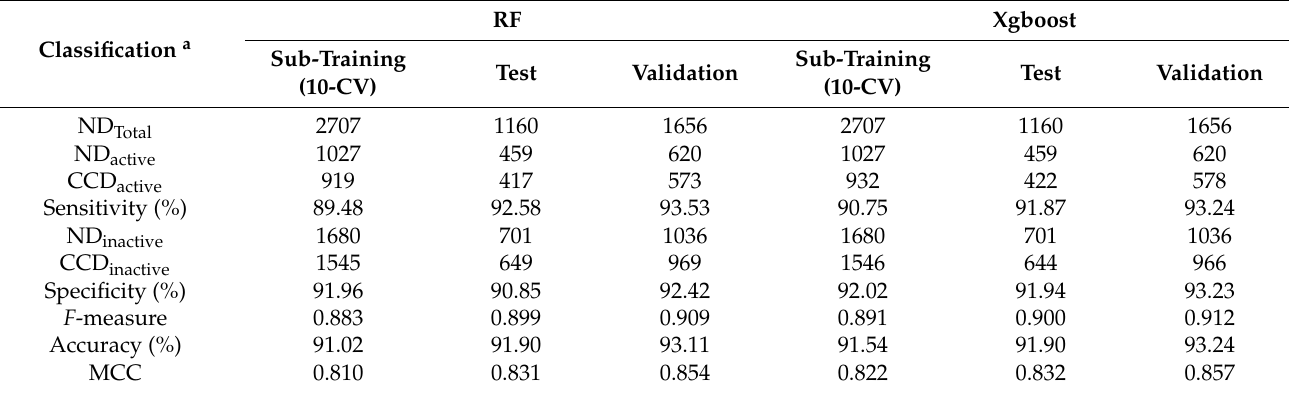
Table 6. Overall predictivity of the RF and Xgboost non-linear